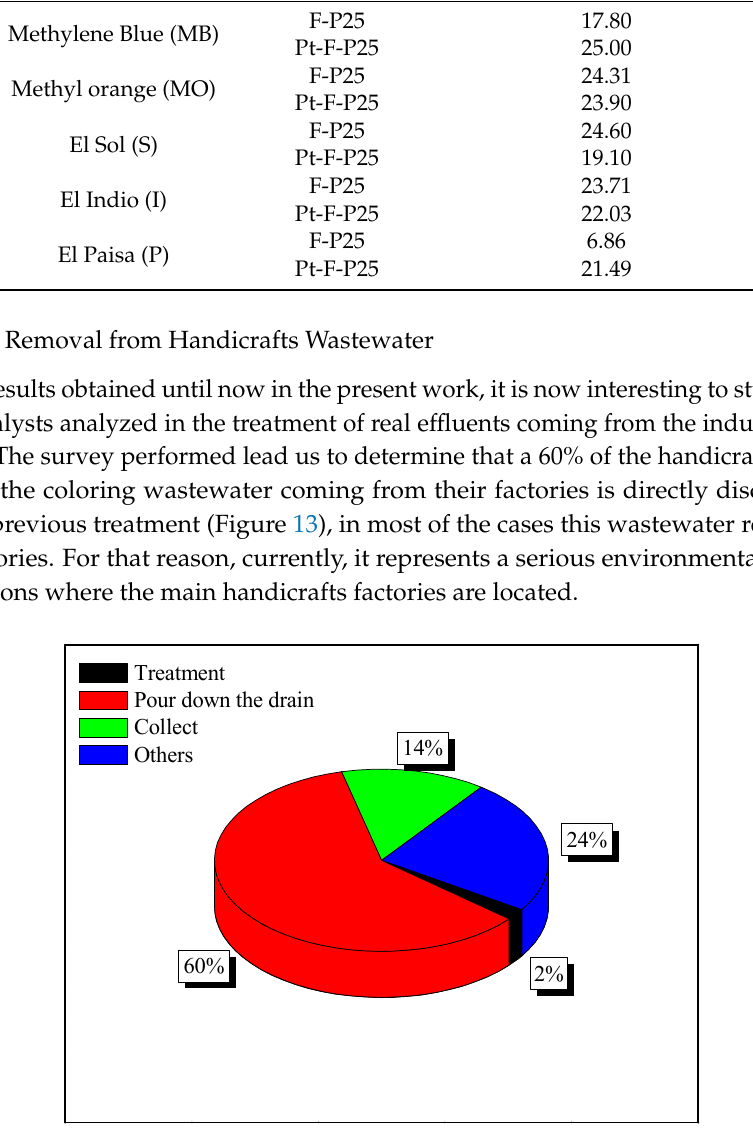
Table 3. Average results of the physicochemical and microbiological analysis for wastewater samples coming from handicrafts factories, before and after 5 h of photocatalytic treatment.